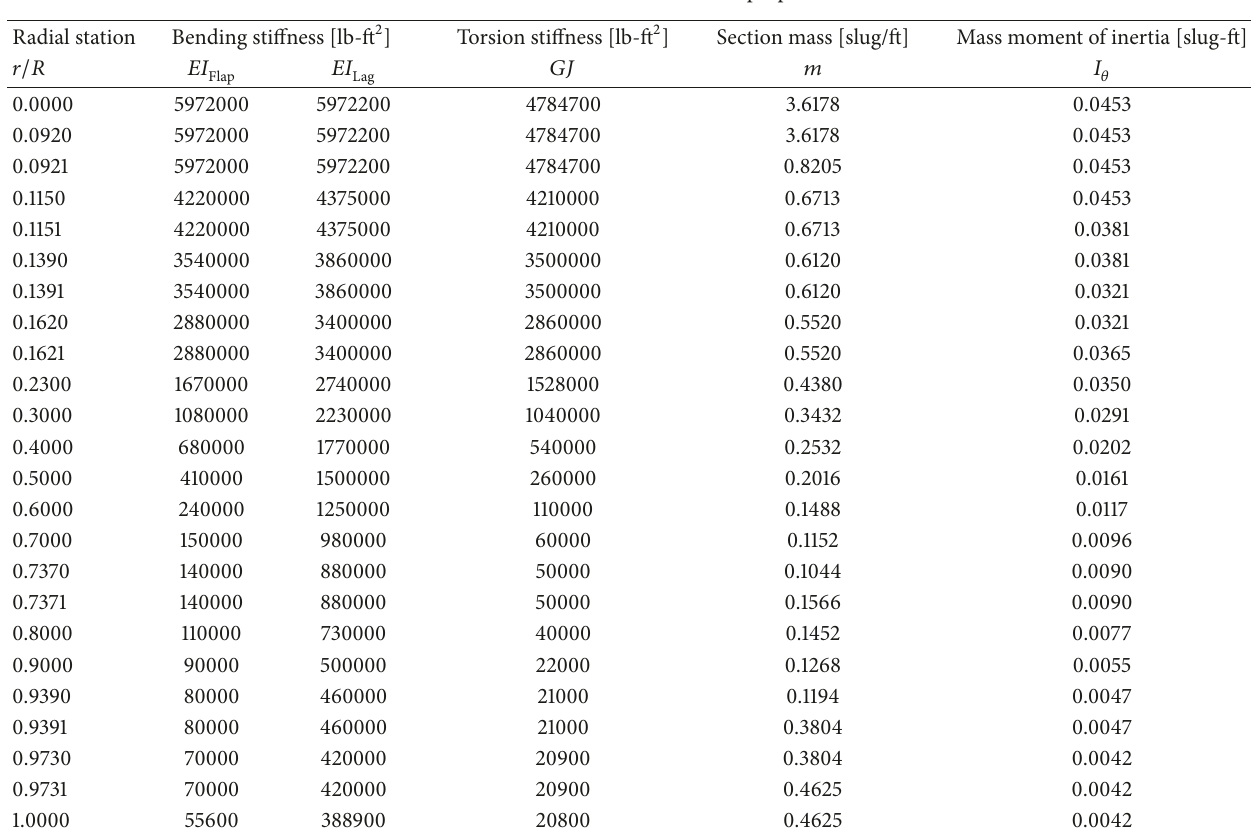
Table 2: Blade cross-sectional beam